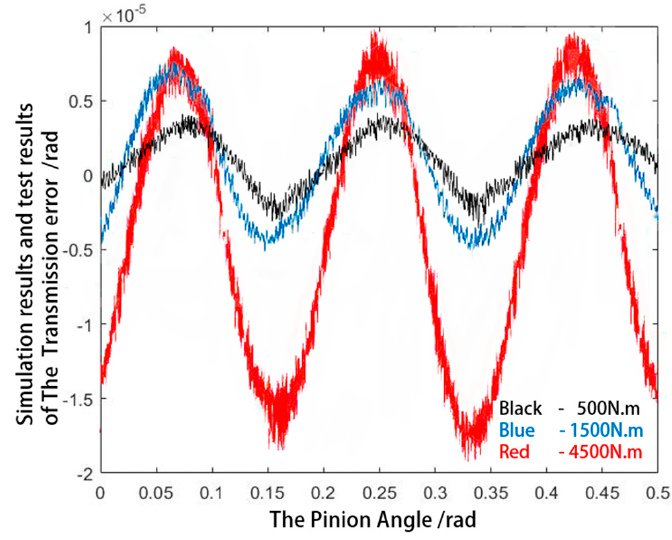
19 of 21 Figure 19. Main components of circular grating equipment. The test results of transmission errors after translation are shown in Figure 20 below. We can know that the absolute value and peak to peak of test results are larger than that of FEM results, but the variation trend and fluctuation period of the two are similar. We can further analyze the difference between test results with simulation results. We define the rotation speed of gear as (cid:2205) (cid:2869) = (cid:2254) (cid:2869) , and the rotation speed of gear (cid:2205) (cid:2870) = (cid:1861)((cid:1872))(cid:2254) (cid:2870) . (cid:1861)((cid:1872)) is instantaneous transmission ratio. Relative speed of gear and pinion in meshing position can be represented as: (cid:2204) (cid:2869)(cid:2870) = (cid:2254) (cid:2869) × (cid:2174) (cid:2870) − (cid:1861)((cid:1872))(cid:2254) (cid:2870) × (cid:2174) (cid:2869) (49) For the meshing equation (cid:2204) (cid:2869)(cid:2870) ∙ (cid:2170) (cid:2870) = 0 , we can get (cid:1861)((cid:1872)) : (cid:1861)((cid:1872)) = ((cid:2254) (cid:2870) , (cid:2174) (cid:2870) , (cid:2170) (cid:2870) ) ((cid:2254) (cid:2869) , (cid:2174) (cid:2869) , (cid:2170) (cid:2869) ) = ((cid:2254) (cid:2870) , (cid:2200) (cid:2870) , (cid:2196) (cid:2870) ) ((cid:2254) (cid:2869) , (cid:2200) (cid:2869) , (cid:2196) (cid:2869) )